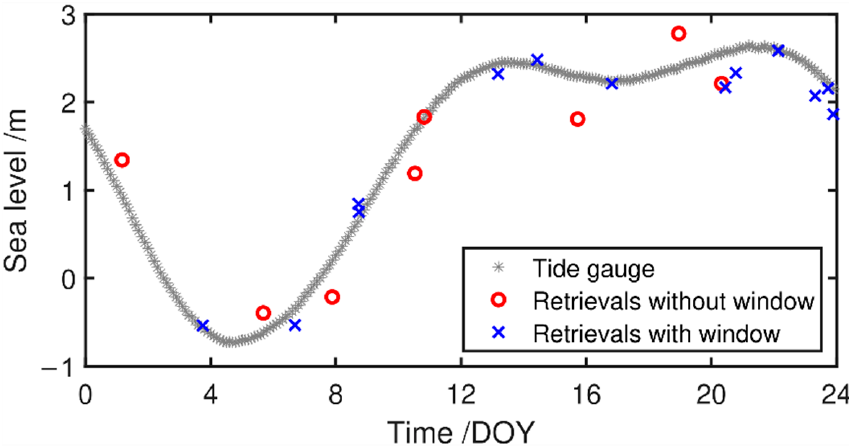
Figure 10. Sea surface heights estimated from GPS PE arcs for site SC02 on DOY 1, 2022. Red: LSP results for raw observation arcs; Blue: the additional LSP results after using a sliding window.